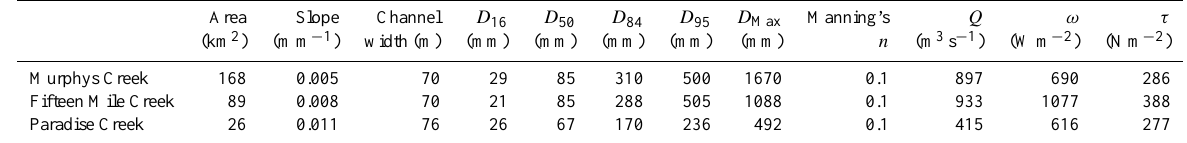
Table 2. Reach characteristics and calculated discharge, stream power and shear stress for the 2011 flood in each of the three field reaches.